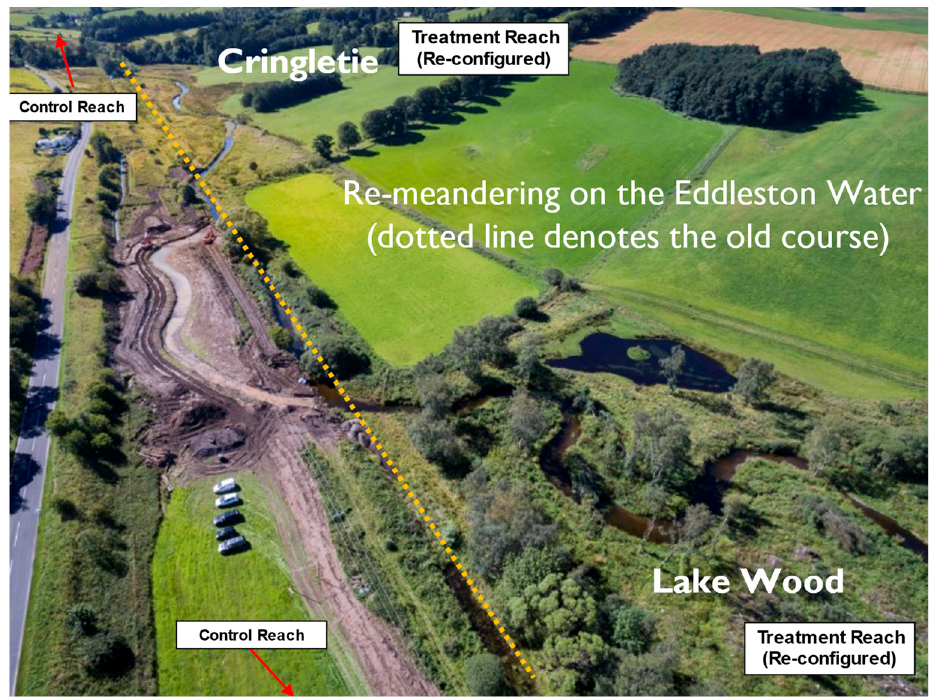
Figure 7. Aerial photograph of Eddleston Water restoration 2018—remeanders at Lake Wood and Cringletie looking south downstream.